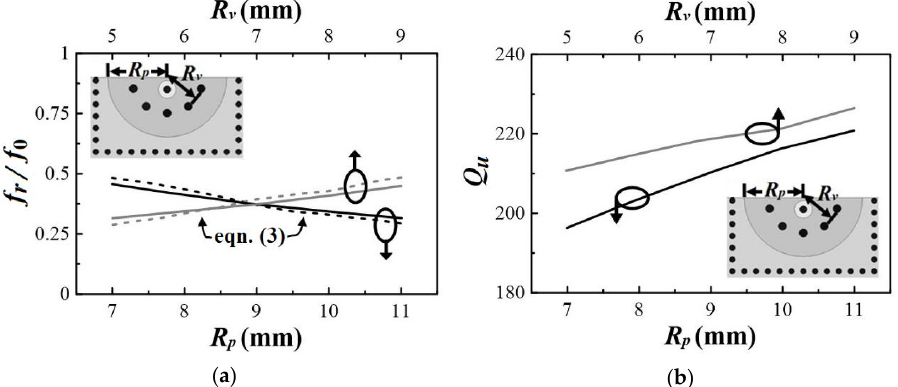
Figure 7. Simulated curves of ( a ) f r/ f 0 and ( b ) Q u vs. R p (radius of the embedded patch) and R v (radius of the semicircular via-ring).